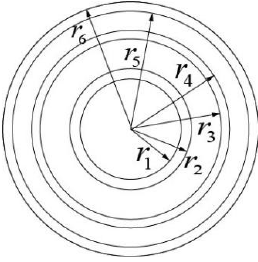
Figure 2. The schematic diagram of the shaft wall structure.